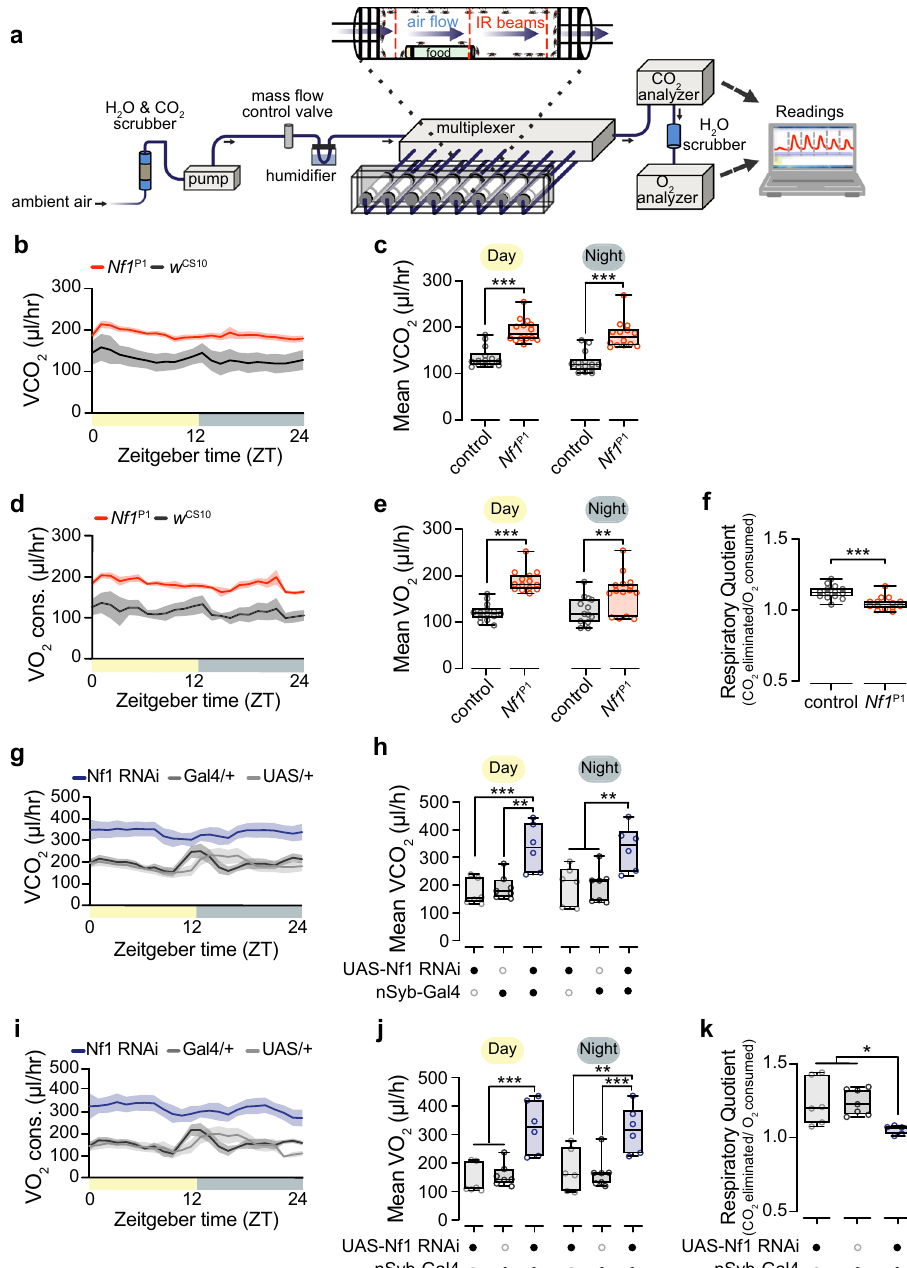
Fig. 3 Loss of Nf1 increases metabolic rate across the circadian photoperiod. a O 2 consumption and CO 2 production, measured with indirect calorimetry. b CO 2 production measured in Nf1 P1 mutants and w CS10 controls, plotted in 1-h bins across the circadian photoperiod. c Quanti fi cation of CO 2 production from ( b ) during day and night periods. *** p <0.001 (Sidak, two-sided; n = 14 per genotype). d O 2 consumption measured in Nf1 P1 mutants and w CS10 controls. e Quanti fi cation of O 2 consumption from ( d ) during day and night periods. Day experimental *** p <0.001 re: control, night experimental ** p = 0.003 re: control. (Sidak, two-sided; day: n = 14 per genotype, night: n = 13 control, n = 14 Nf1 P1 ). f Respirometry quotient in Nf1 P1 mutants and w CS10 controls. *** p <0.001 (Mann – Whitney, two-sided; n = 14). g CO 2 production, comparing pan-neuronal nSyb>RNAi with heterozygous controls. h Quanti fi cation of CO 2 production from ( g ) during day and night periods. Day experimental *** p = 0.001 re: UAS-Nf1 RNAi/ + , ** p = 0.001 re: nSyb-Gal4/ + . Night experimental ** p = 0.004 re: UAS-Nf1 RNAi/ + , ** p = 0.002 re: nSyb-Gal4/ + . (Sidak, two-sided; n = 6 UAS-Nf1 RNAi/ + , n = 7 nSyb-Gal4/ + , n = 6 experimental group). i O 2 consumption, comparing pan-neuronal nSyb>RNAi lines with heterozygous controls. j Quanti fi cation of O 2 production from ( i ) during day and night periods. Day experimental *** p = 0.0001 re: UAS-Nf1 RNAi/ + , *** p = 0.003 re: nSyb-Gal4/ + . Night experimental ** p = 0.003 re: UAS-Nf1 RNAi/ + , *** p = 0.001 re: nSyb- Gal4/ + . (Sidak, two-sided; n = 6 UAS-Nf1 RNAi/ + , n = 7 nSyb-Gal4/ + , n = 6 experimental group). k Respirometry quotient in nSyb>RNAi lines and heterozygous controls. Experimental * p = 0.014 re: UAS-Nf1 RNAi, * p = 0.011 re: nSyb-Gal4/ + (Sidak, two-sided; n = 6 UAS-Nf1 RNAi/ + , n = 7 nSyb-Gal4/ + , n = 6 experimental group). Each “ n ” represents a single respirometer containing 25 animals. Box plots — box: 1st to 3rd quartiles, median: line, whiskers: min – max, individual data points: circles. Data are presented as mean values±SEM in ( b , d , g , and i